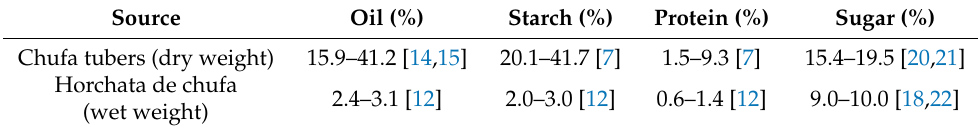
Table 1. Nutritional composition of chufa tubers (dry weight) and Horchata de chufa (wet weight). Source Oil (%) Starch (%) Protein (%) Chufa tubers (dry